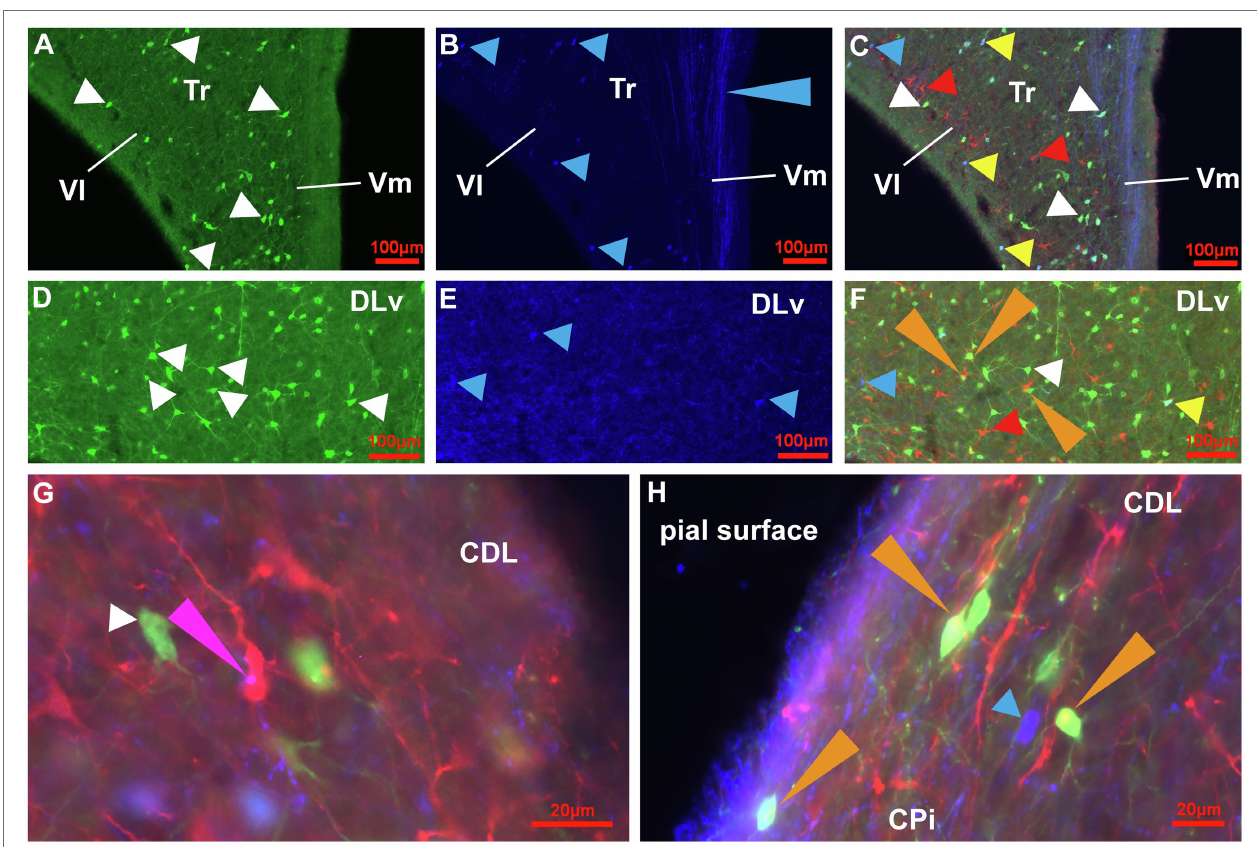
FIGURE 6 | Immunoreactive cell types for CB, CR and DCX in the HF, CDL and CPi of the adult pigeon. (A-C) Detail of the V-Region of the HF at atlas level A4.75. CB+ (green) cells with different size, shape and fiber architecture (white arrowheads) are shown in (A) . CR+ (dark blue) cells (blue arrowheads) and CR+ fibers (blue long arrowhead) are shown in (B) . (C) Overlay of triple-staining for CB, CR and DCX (red). White arrowheads point to CB+ cells (green), blue arrowheads point to CR+ cells (dark blue). Red arrowheads point to DCX+ cells (red). Yellow arrowheads point to CB+/CR+ (light blue-green) double labelled cells. (D-F) Detail of DLv of the HF at atlas level A7.00. CB+ (green) cells with different size, shape and fiber architecture (white arrowheads) are shown in (D) . CR+ (dark blue) cells (blue arrowheads) are shown in (E) . (F) Overlay of triple-staining for CB, CR and DCX (red). White arrowhead points to CB+ cells (green), blue arrowhead points to CR+ cells (dark blue). Red arrowhead points to DCX+ cells (red). Yellow arrowhead points to CB+/CR+ (light blue-green) double labelled cells. Orange long arrowheads point to CB+/DCX+ (yellow) double labelling. (G) Magnification of cell types and fibers in CDL at atlas level A7.00. The white arrowhead points to a CB+ (green) cell of stage 3, the pink long arrowhead points to CR+(blue)/DCX+(red) double labelling showing that CR + fibers contact DCX+ ovoidal cells of stage 3 appearing in pink. (H) Magnification of cell types and fibers in the transition area between CPi and CDL at atlas level A6.50. The blue arrowhead points to a CR+ (blue) ovoidal cell of stage 3. The orange arrowheads point to CB+(green)/DCX+(red) double labelled cells appearing in yellow.